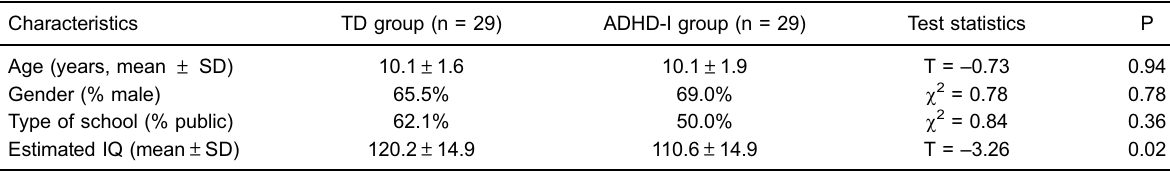
Table 1. Sociodemographic characteristics of the sample